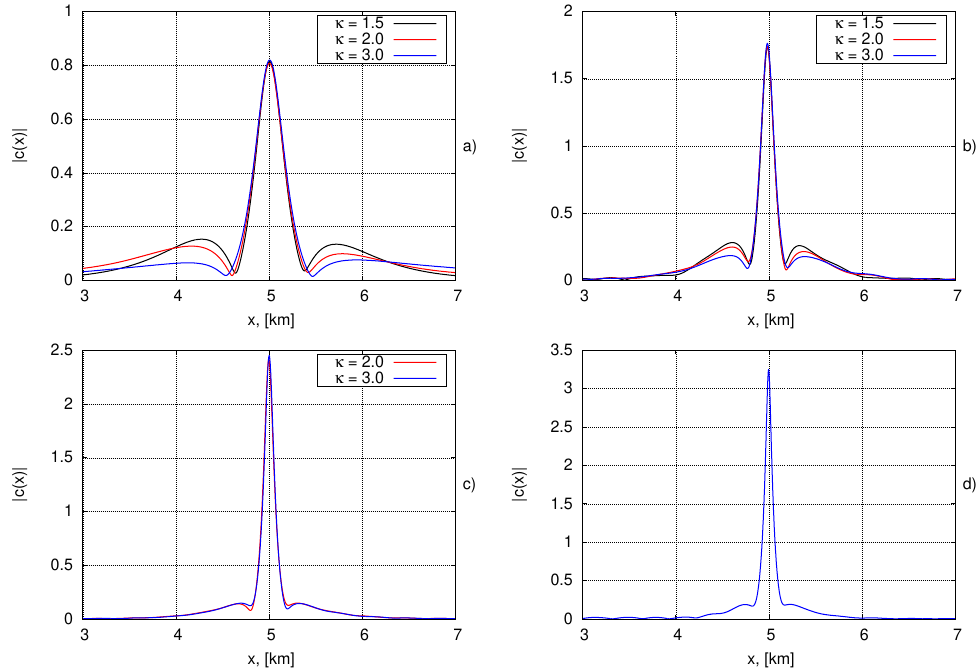
Figure 2. The examples of initial Nonlinear Schrödinger equation (NLSE) bi-solitons for different κ and µ ini = 0.1.